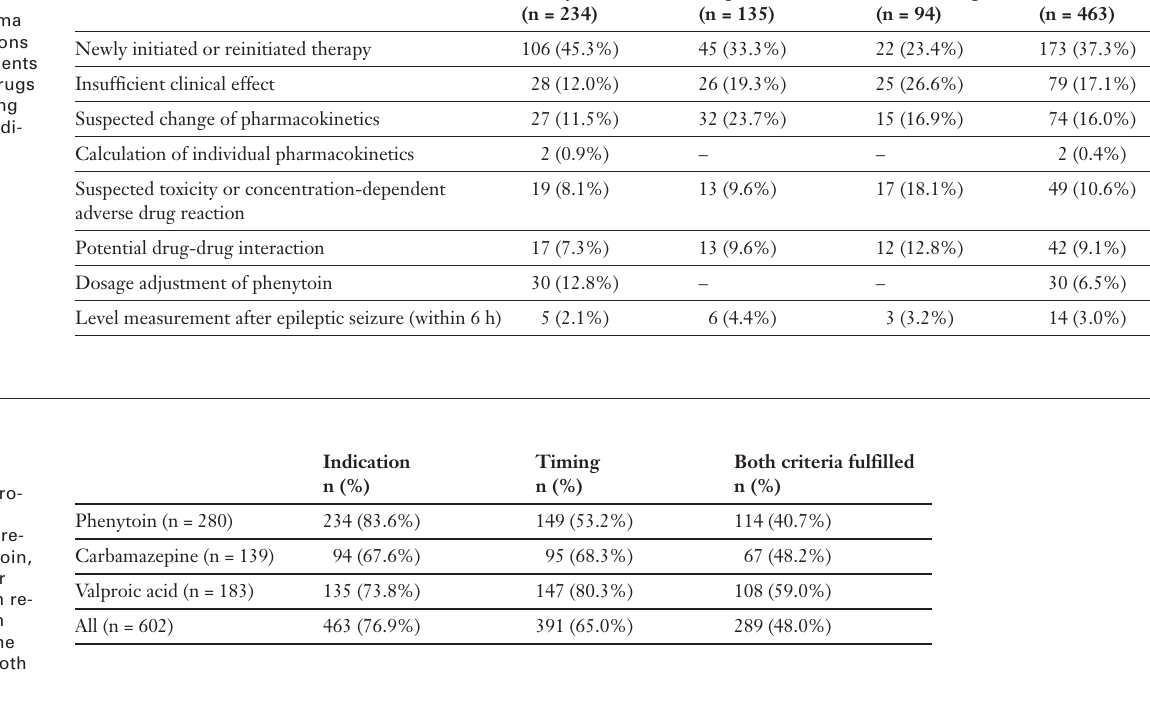
Reasons for plasma level determinations of 463 measurements of antiepileptic drugs assessed as having an appropriate indi- cation.